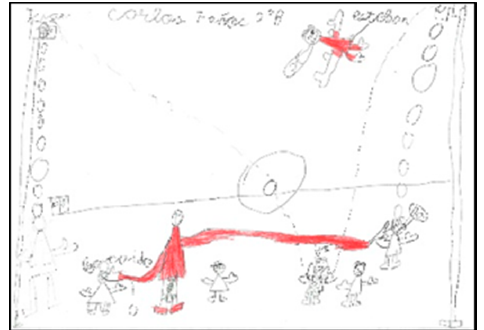
Figure 4. Human body proportion. Carlos. 2°B.